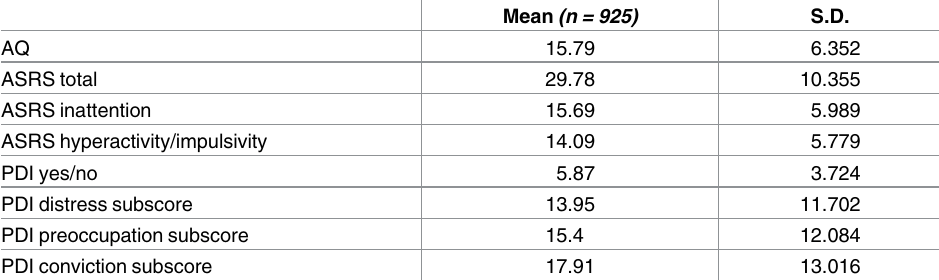
Table 1. Distributions of the scores on AQ, ASRS (total score, ASRS-inattention and ASRS- hyperac- tivity/impulsivity), PDI (yes/no, and three